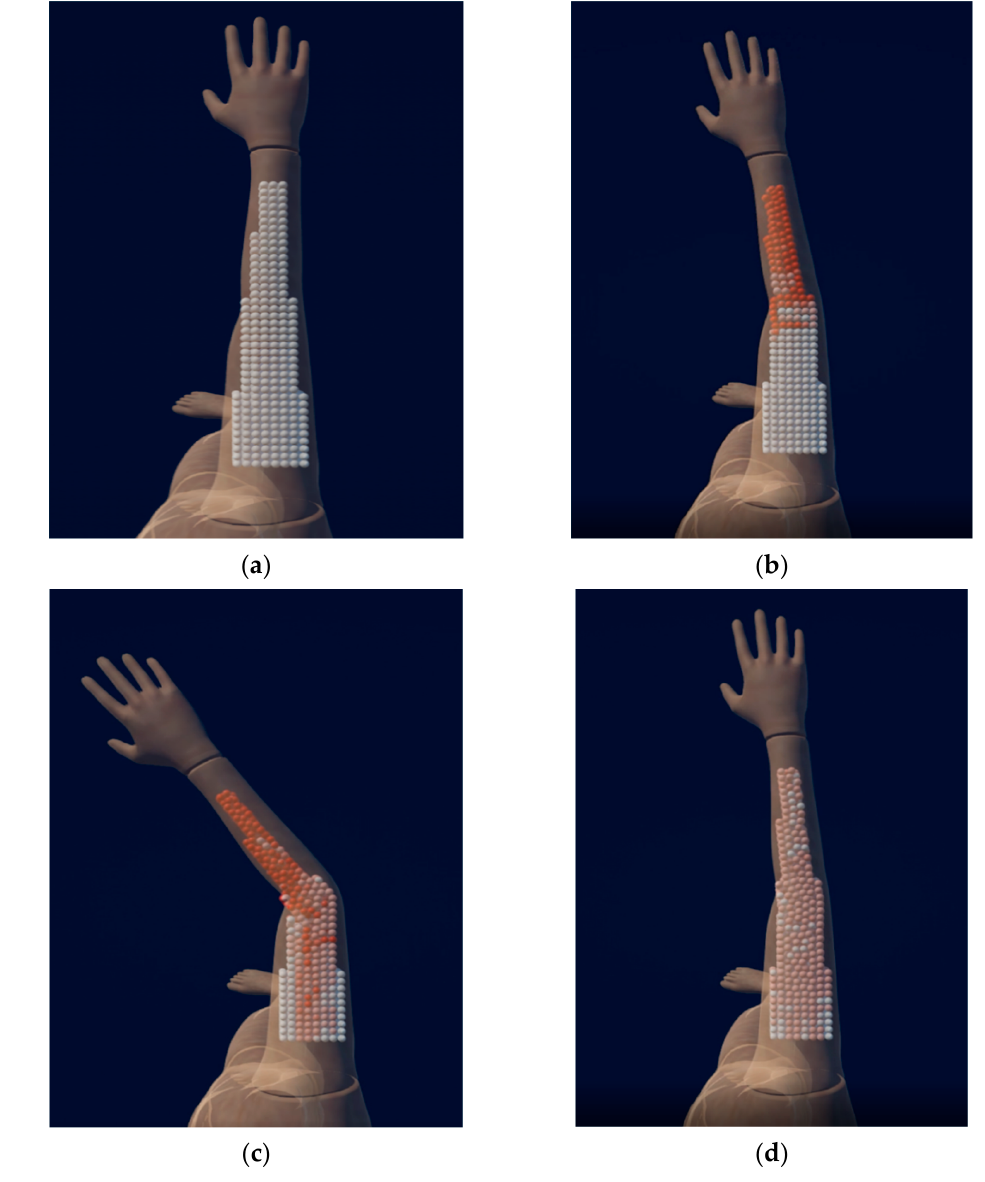
Figure 3. Simulation of elasticity when subjected to an external force. The color of the particles indicates the force they receive: ( a ) initial state; ( b ) starting to receive external force from the upper right; ( c ) flexed elbow joint due to external force; ( d ) bounced back due to elasticity.